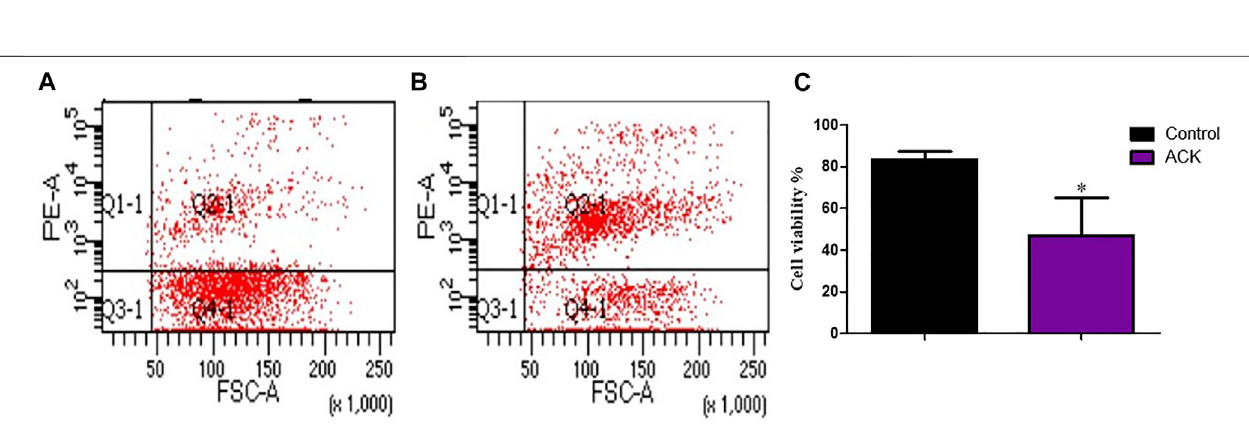
FIGURE9| Theeffectoftheredbloodcelllysateoncellviabilityduringthepreparationofsinglecellsuspension. (A) controlgroup, (B) grouptreatedwithACKlysing buffer, (C) Statistical comparison of the effect of ACK lysing buffer on cell viability. Data are presented as means ± SD; * p value = 0.0266.